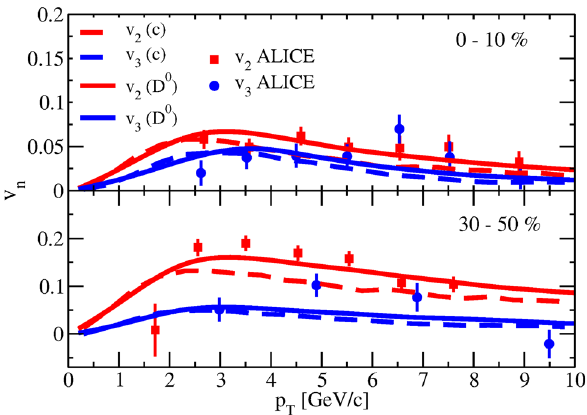
Fig. 1 v 2 and v 3 of charms quarks (dashed lines) and D mesons (solid lines) as a function of p T at mid-rapidity and for centrality classes 0 − 10% (upper panel) and 30 − 50% (lower panel) for PbPb collisions at 5 . 02 TeV. Data are taken from ALICE measurements